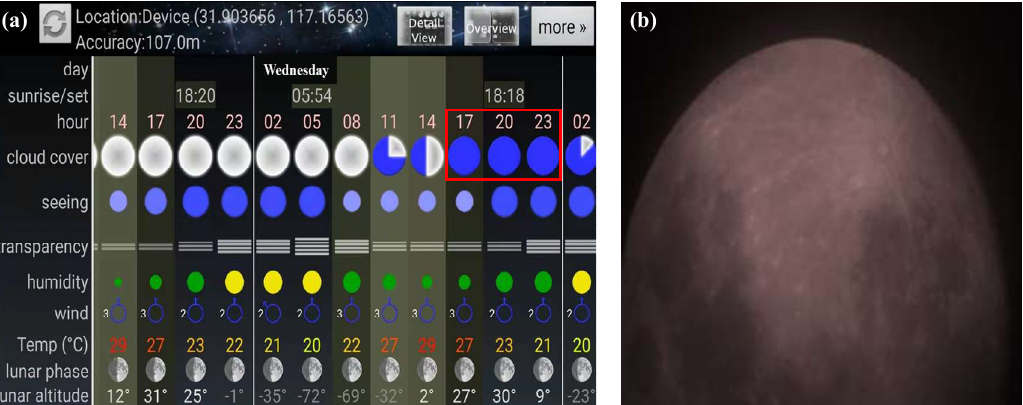
Figure 7. ( a ) Cloud forecast result by Astro Panel (23 June 2021); ( b ) observed image of the